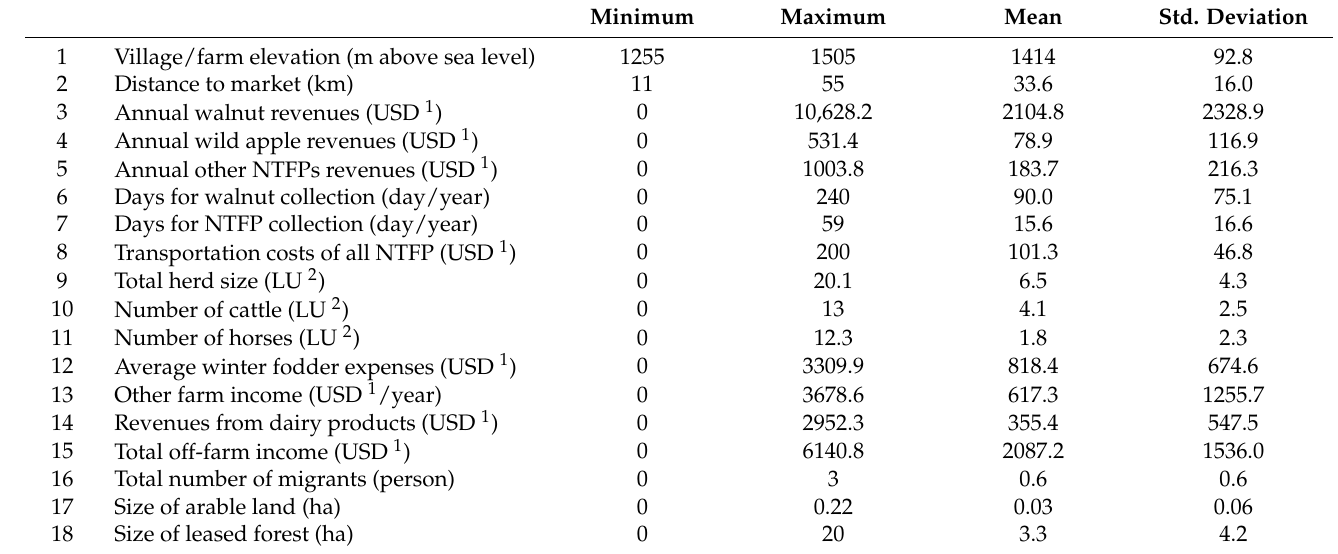
Table 1. Quantitative variables from questionnaires used in PCA ( n =